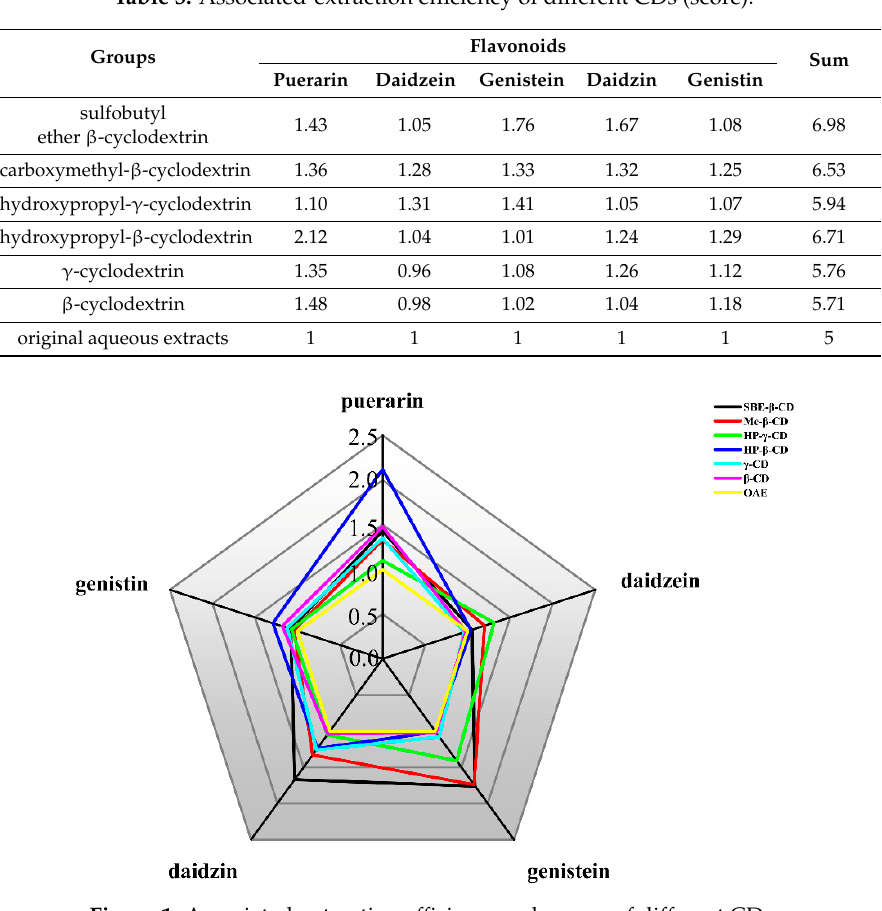
Figure 1. Associated-extraction efficiency radar map of different CDs.